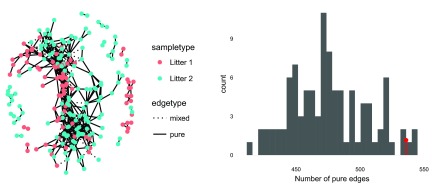
Testing using a Bray-Curtis distance thresholded graph.